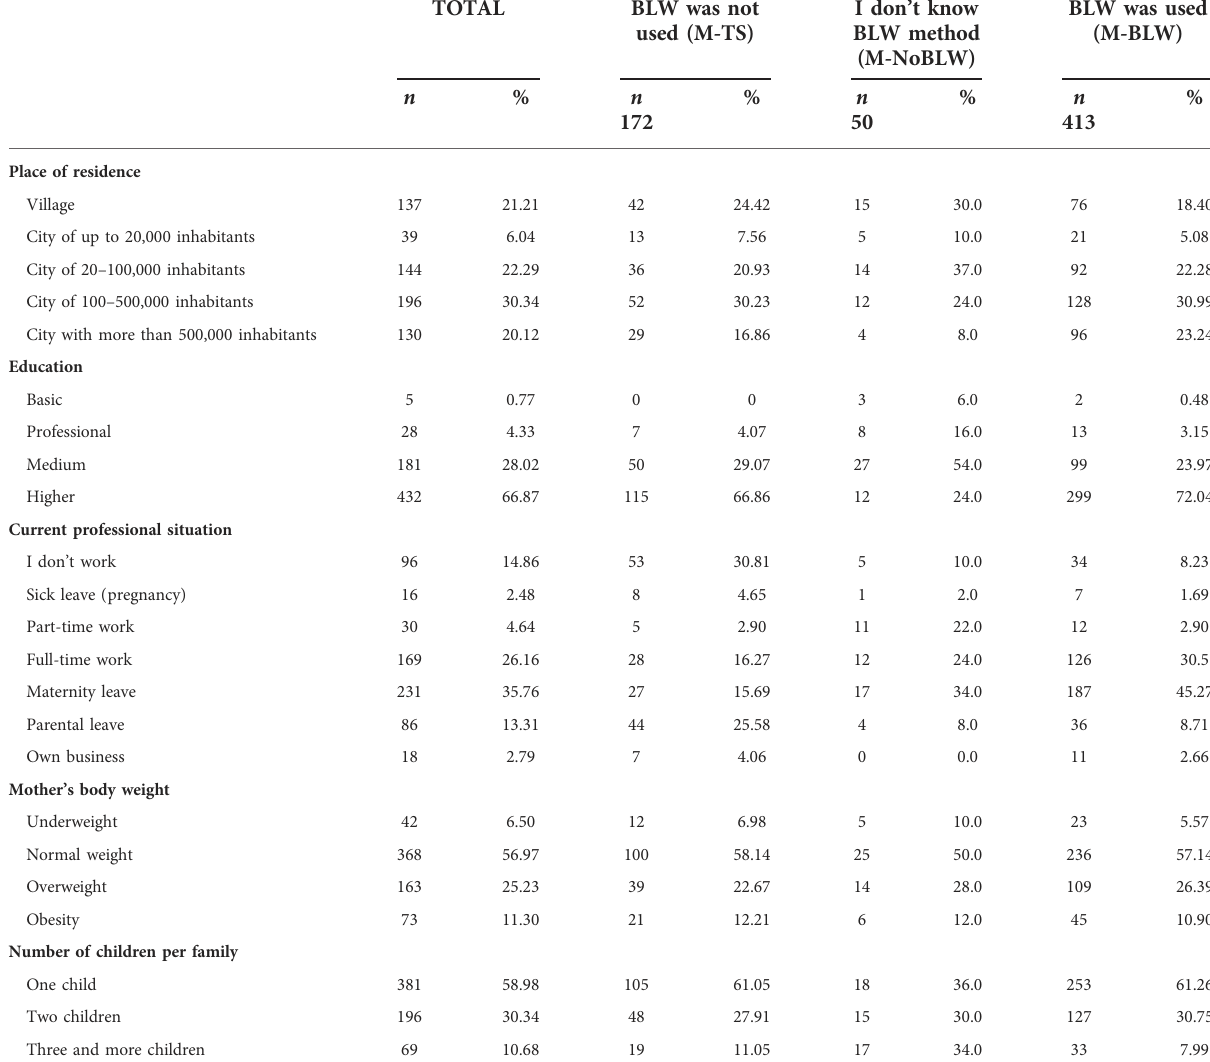
TABLE 2 Characteristics of the study group of mothers ( N